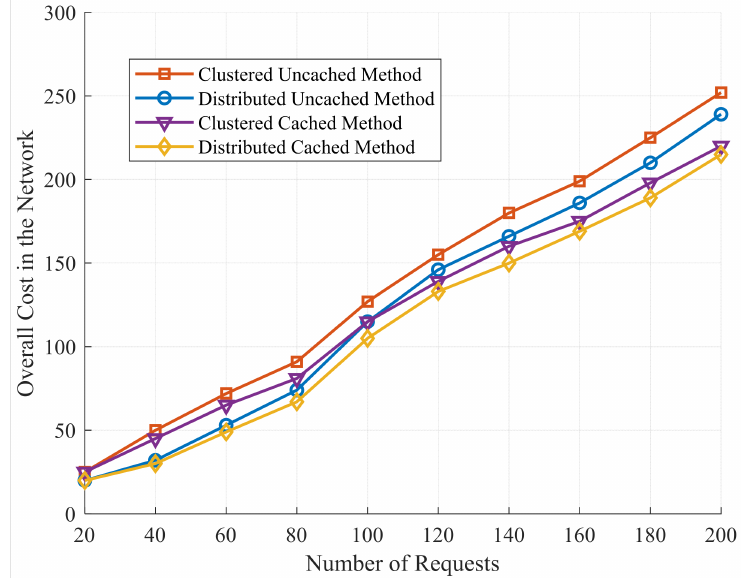
Figure 4. Overall Network Cost for Various MS